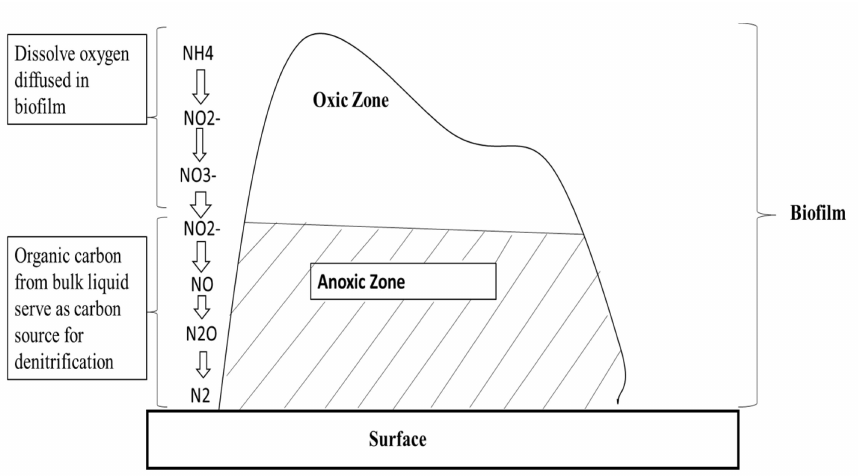
Figure 1. Schematic diagram of a biofilm immobilized onto the